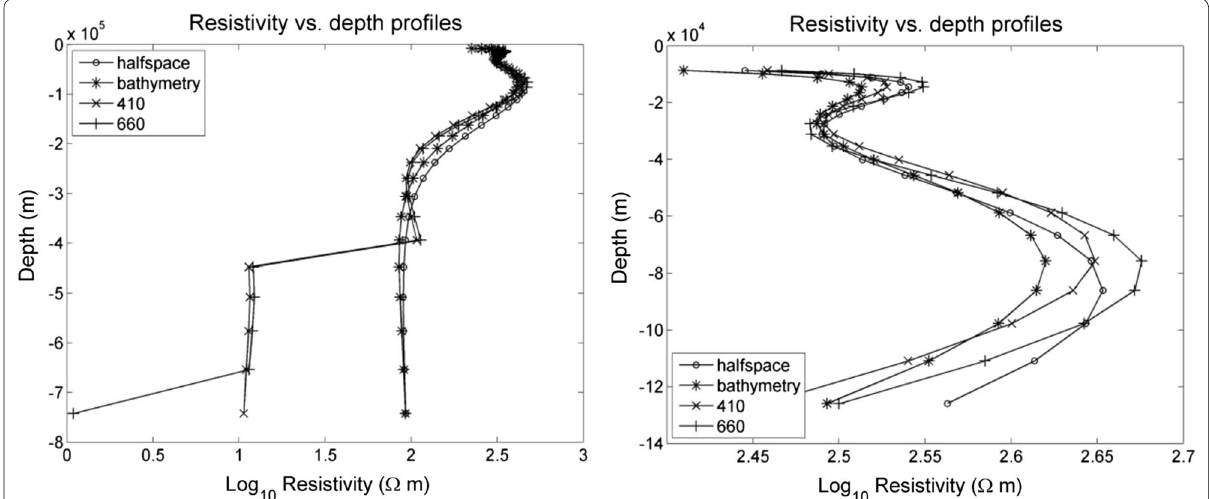
Fig. 4 The averaged resistivity values taken from the inversions with different resistivities for the various prior models for depths of 10 to 750 km (left) and 10 to 140 km